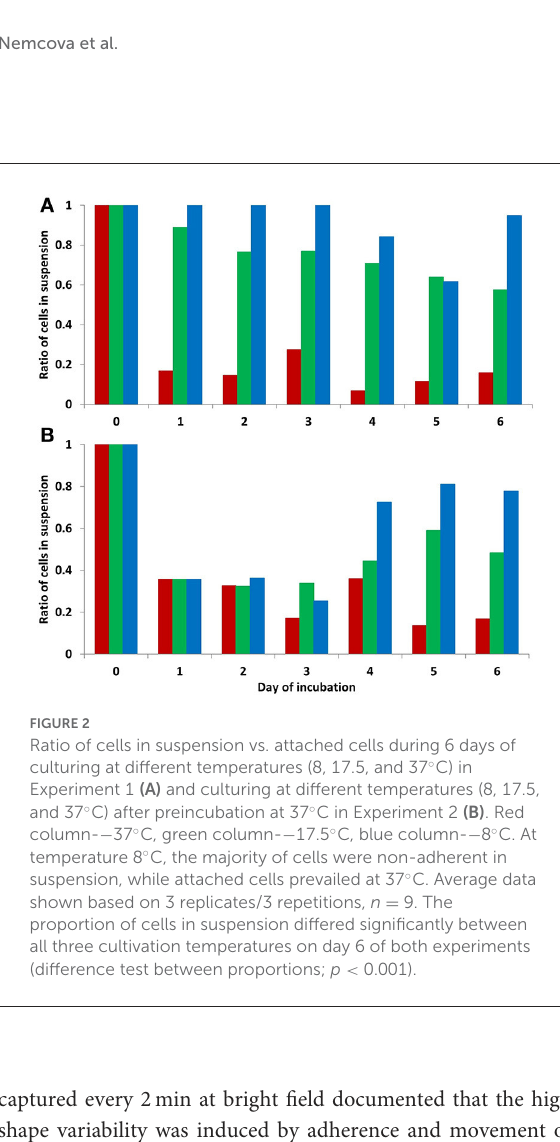
only 15% of detached/newly formed by cellular division cells at the end of cultivation (Table